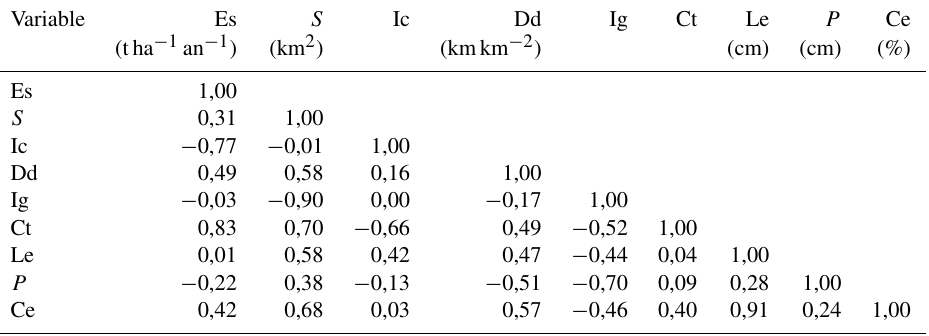
Tableau 2. Matrice de corrélation.